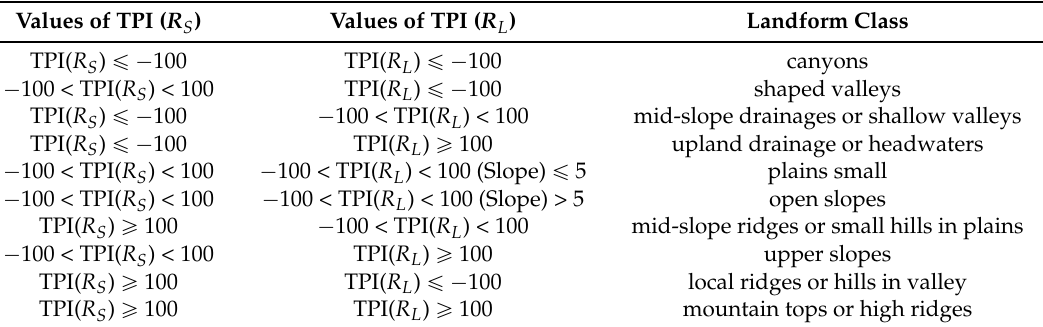
Table 5. Values of TPIs to landform classification [21,22].